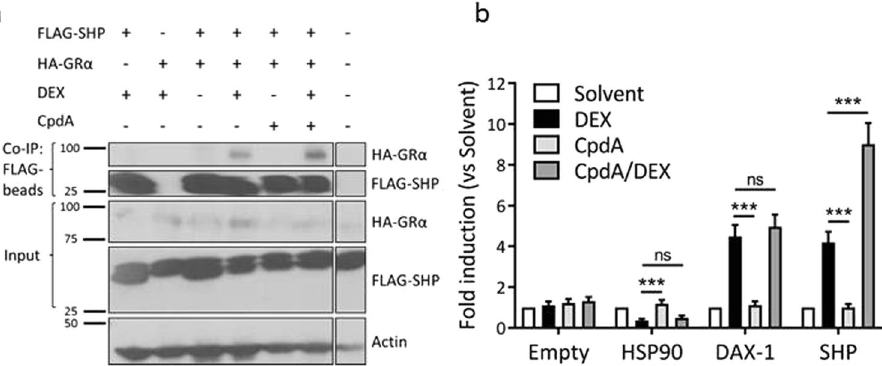
Figure 7. CpdA enhances the interaction of DEX-bound GR α with the cofactor SHP ( a ) Co- immunoprecipitation between Flag-SHP and HA-GR α overexpressed in HEK293T cells (ratio GR/SHP was 1/5). Cells were stimulated with CpdA (10 µ M) 1 h before DEX (1 µ M) and lysed 3 h after DEX stimulation (n = 4, representative figure). ( b ) Mammalian protein-protein interaction technique (MAPPIT). Empty prey is used as negative control, HSP90 prey as selective control. Cells were stimulated with leptin (100 ng/ml) and leptin in combination with DEX (1 µ M) and/or CpdA (10 µ M) for 24 h or were left untreated. Luciferase measurements were performed in triplicate (normalized by β -galactosidase expression) and normalized by untreated values. Reporter activities are expressed as relative induction factor versus Solvent. Three independent replicates were performed. Means + SE, obtained as predictions from the HGLMM fitted to the data, are shown on the original scale. The significance of ligand effects on binding activity, estimated as differences (on the transformed scale) to the reference level DEX, were assessed using a t-test ( * p < 0.05; ** p < 0.01; *** p <